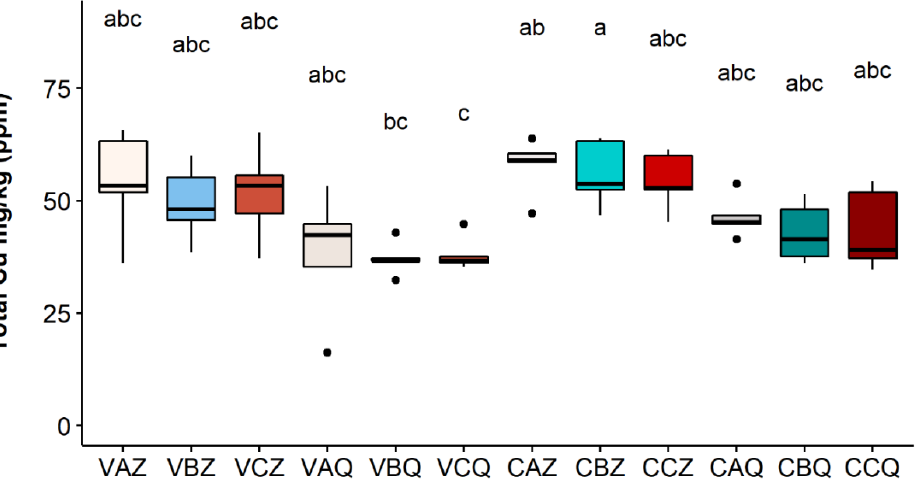
Figure 6. Total Cu concentration in each sample in 2021. Lower case letters refer to Dunn’s multiple comparisons (Benjamini–Hochberg p -value adjustment, α -level = 0.05). Codes legend: the first letter refers to the vineyard; (C) Castelplanio, (V) Varano. The second letter refers to the thesis: (A) Cu treatments, (B) Alternate treatments with Cu and chitosan, and (C) Chitosan treatments. The third letter refers to the depth: (Z) 0–20 cm, (Q) 20–40 cm.